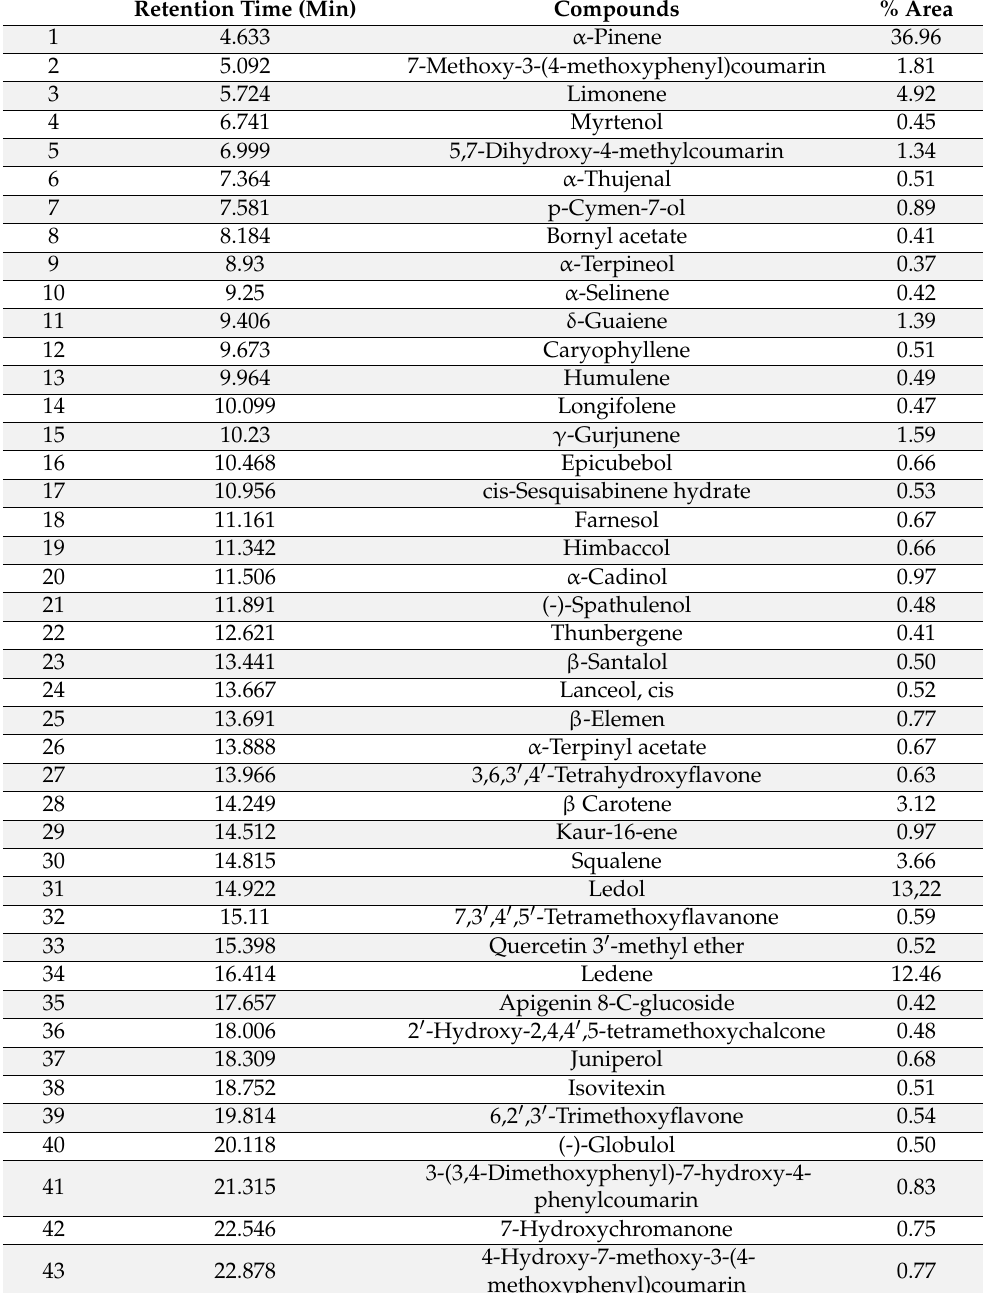
Table 1. Results of the gas chromatography–mass spectrometry (GC/MS) analysis of Boswellia Sacra